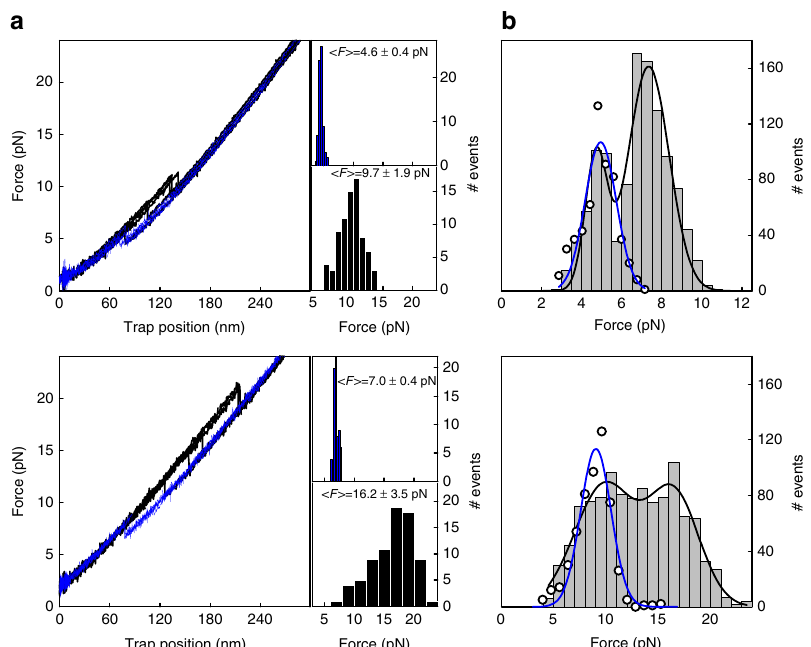
Fig. 2 Two types of Arc-L1-Arc molecules. a Left. Force – extension curves of the unfolding (black) and refolding (blue) of two Arc-L1-Arc-DNA molecules (upper and bottom panels). Right. Force distributions of refolding (blue bars) and unfolding (black bars) events obtained from the force – extension curves of the same two molecules. The average force values and standard deviations are indicated in each graph. The force distribution histograms contain a total of 154 (upper) and 151 (bottom) transitions, respectively. b Force distribution of folding (upper, n = 1108) and unfolding (bottom, n = 1074) rips obtained upon stretching of 32 Arc-L1-Arc molecules (gray bar histograms). The continuous lines in black represent the fi t to a sum of two Gaussian functions. Fitting parameters for refolding force distributions, μ 1 = 4.7, μ 2 = 7.3, σ 1 = 0.5, σ 2 = 1 and unfolding distribution: μ 1 = 10, μ 2 = 16.5, σ 1 = 3, σ 2 = 2.5. The force distribution for the refolding and unfolding of 12 pARC molecules is superimposed as white circles, and the continuous blue line represents its fi t to a Gaussian function. Fitting parameters: μ refolding = 5, μ unfolding = 9, σ refolding = 0.8, σ unfolding =